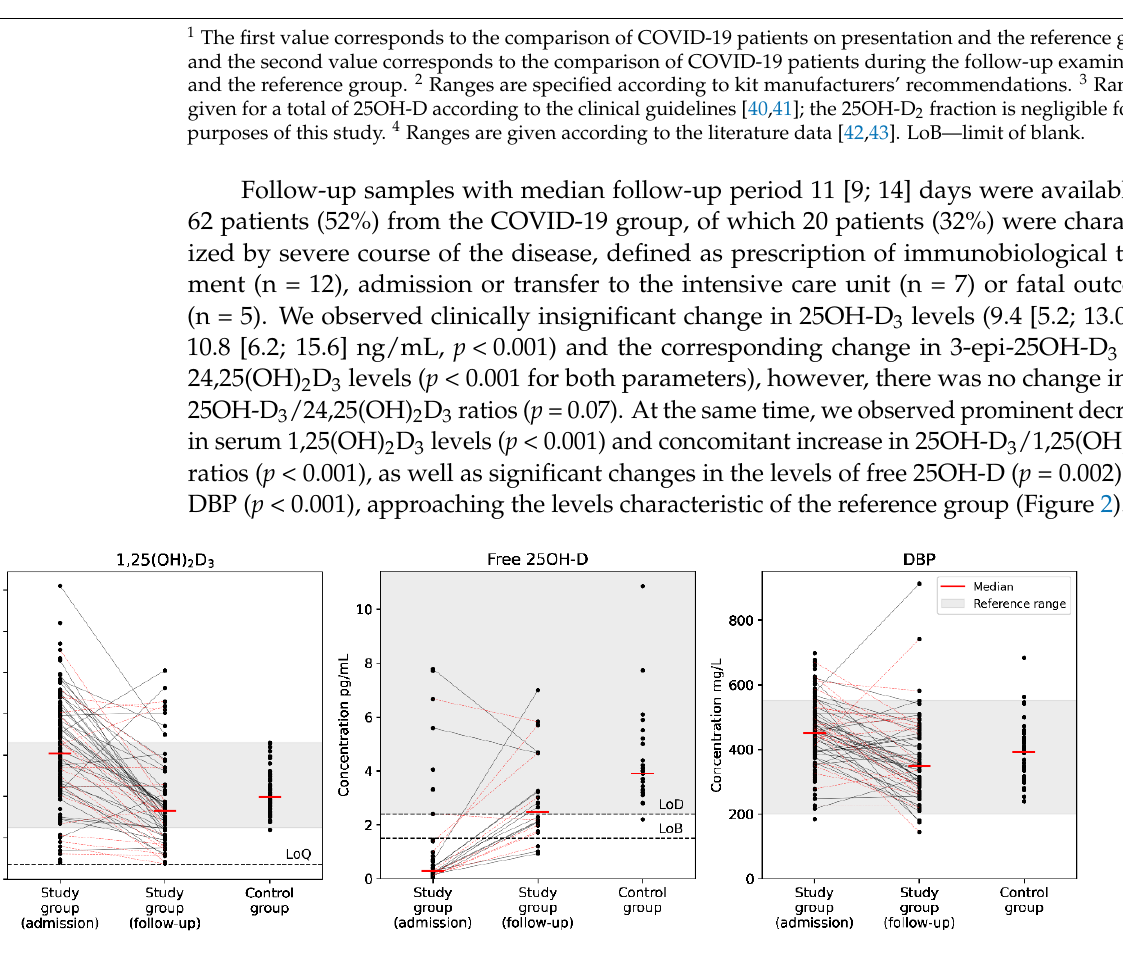
Figure 2. Dynamic evaluation of active vitamin D metabolite (1,25(OH) 2 D 3 ), free 25OH ‐ D, and vitamin D ‐ binding protein (DBP) concentrations in patients with COVID ‐ 19 and comparison to the reference group. Data are shown as individual values. Limits of blank (LoB), detection (LoD), and quantitation (LoQ) are shown. Red dotted lines correspond to patients with a severe course of COVID ‐ 19.